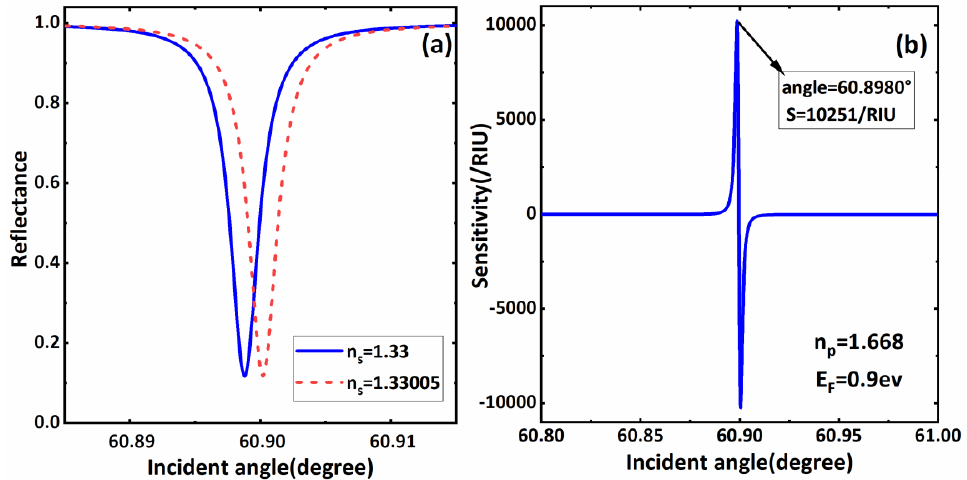
Figure 2. ( a ) The reflection spectrum versus incident angle when n s = 1.33 and n s = 1.33005 respectively; ( b ) The sensitivity of sensor varies with incident angle when the refractive index change value of the sensing layer is Δ n s = 5 × 10 − 4 .